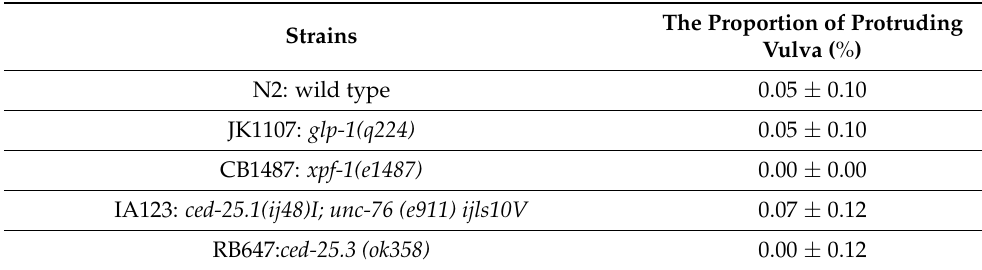
Table A1. The proportions of protruding vulva of strains used in this article under the condition of sham-irradiation. Results are means ± SD ( n ≥